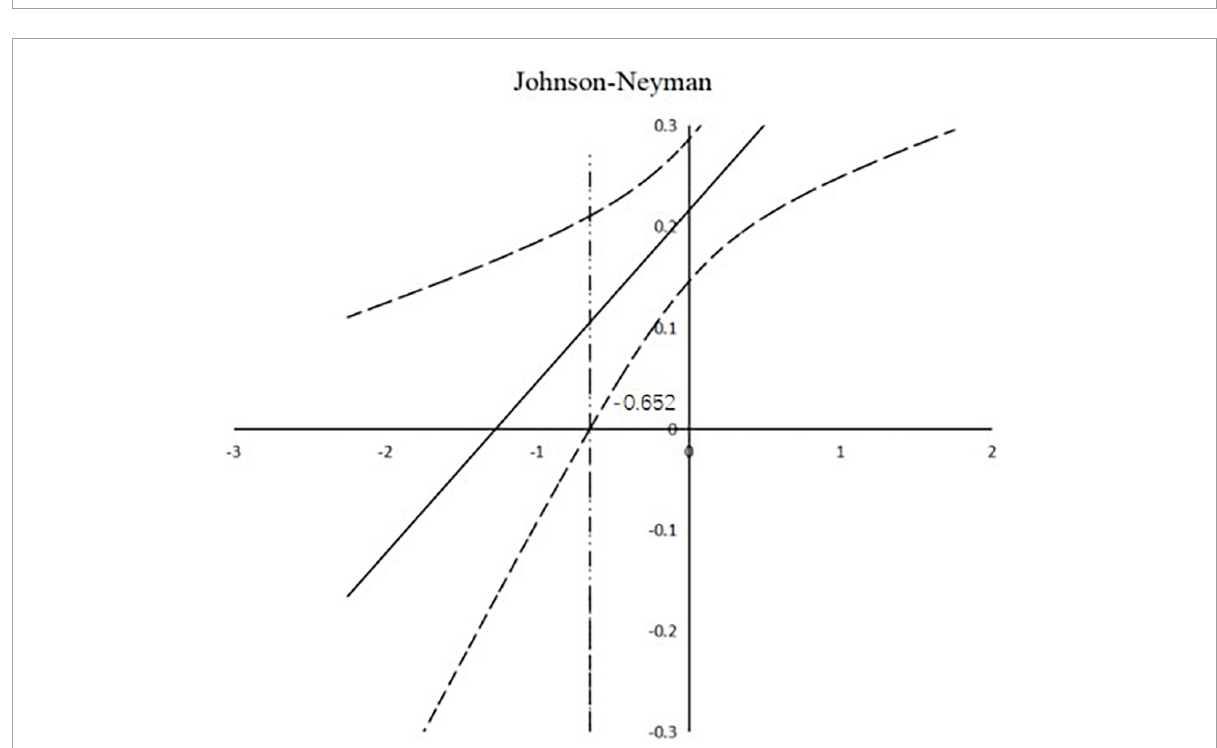
FIGURE3 The relationship between resilience and self-efficacy for high and low scores for creativity, using the Johnson-Neyman technique